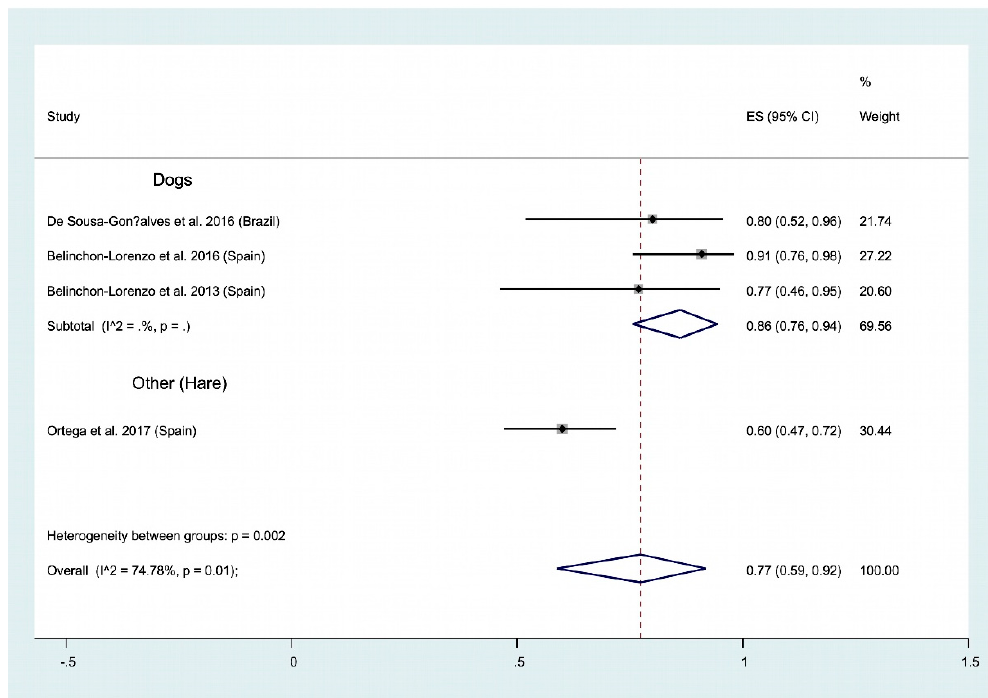
Figure 10. Forest plot representation of the extracted data for hair/bristles using molecular detection methods.